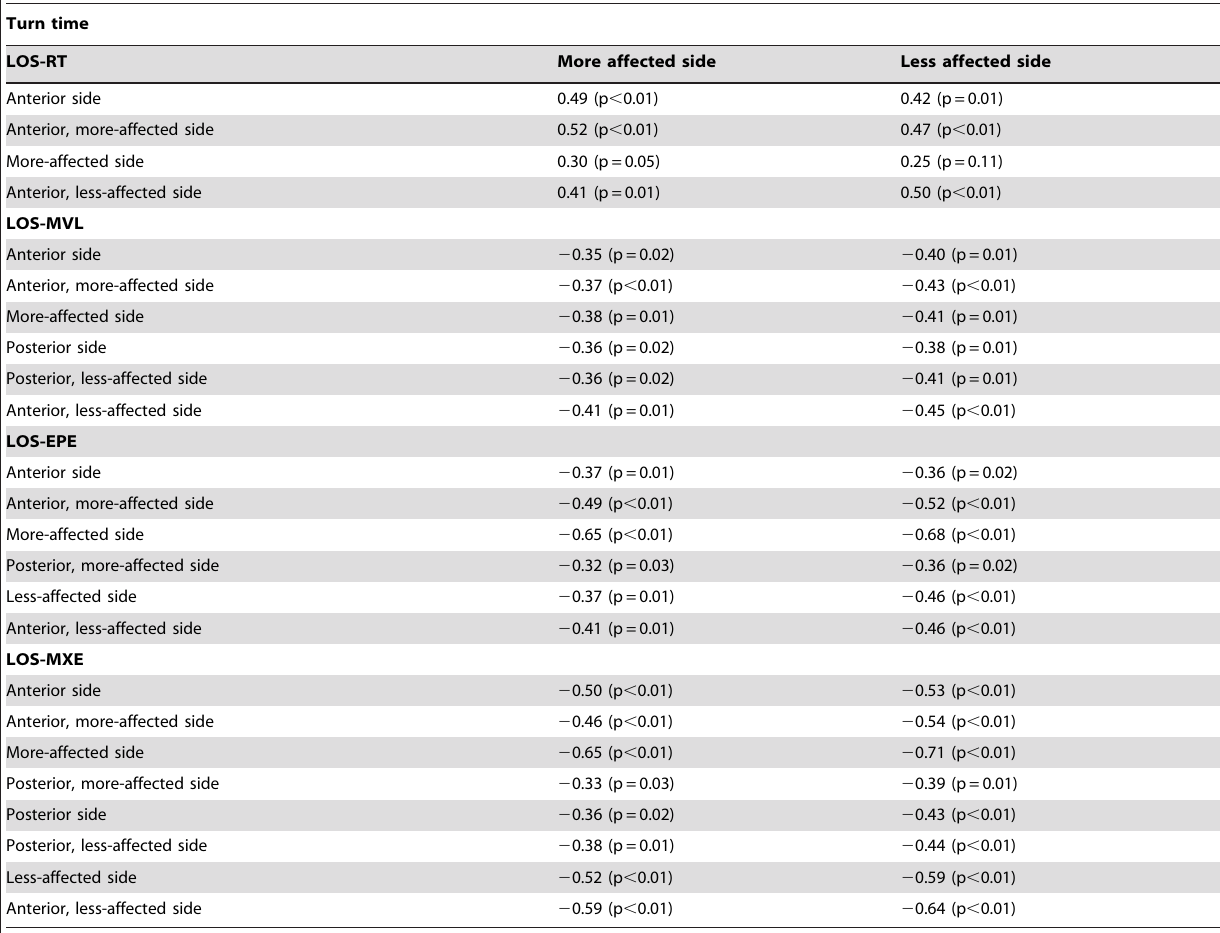
Table 4. Correlation coefficients between turn time and limits of